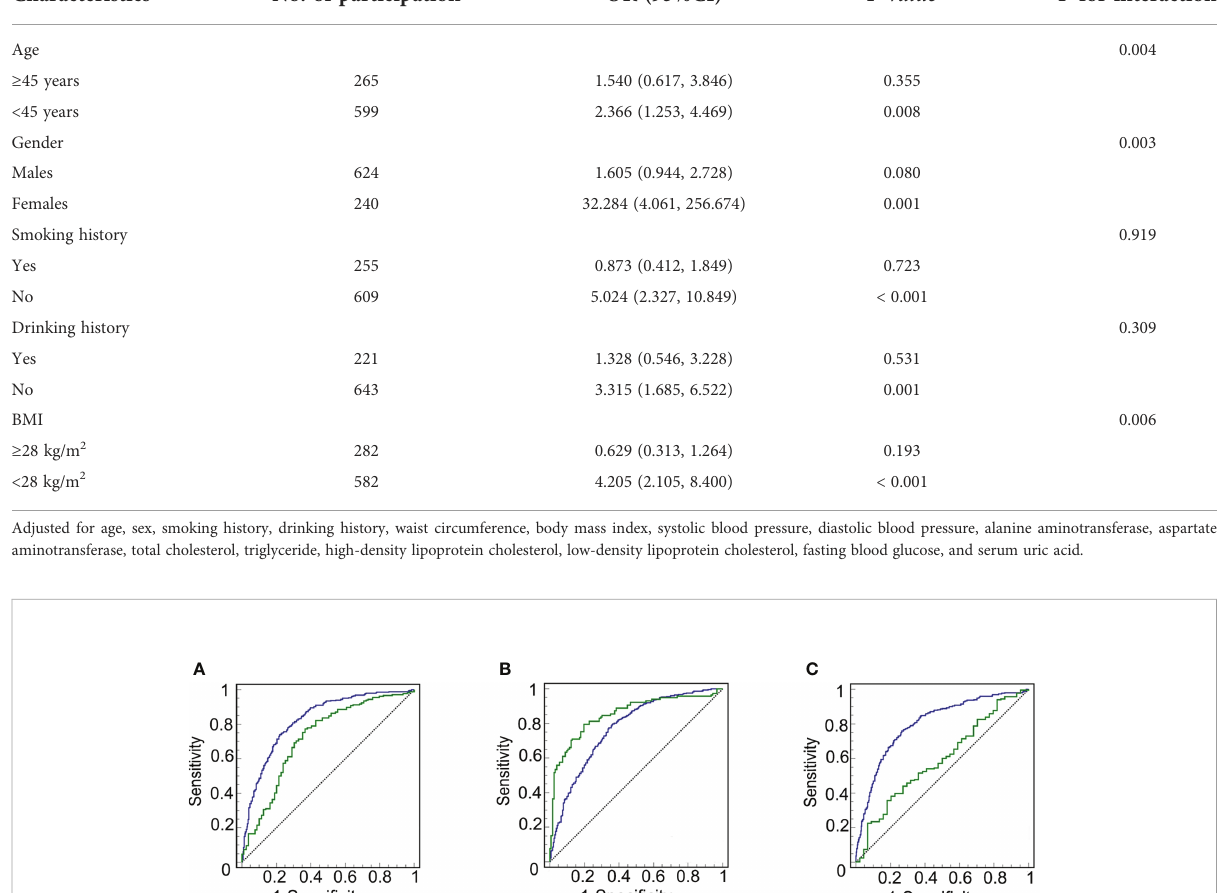
TABLE 3 Effect of magnitude of CMI on MAFLD risk strati fi ed by subgroups.